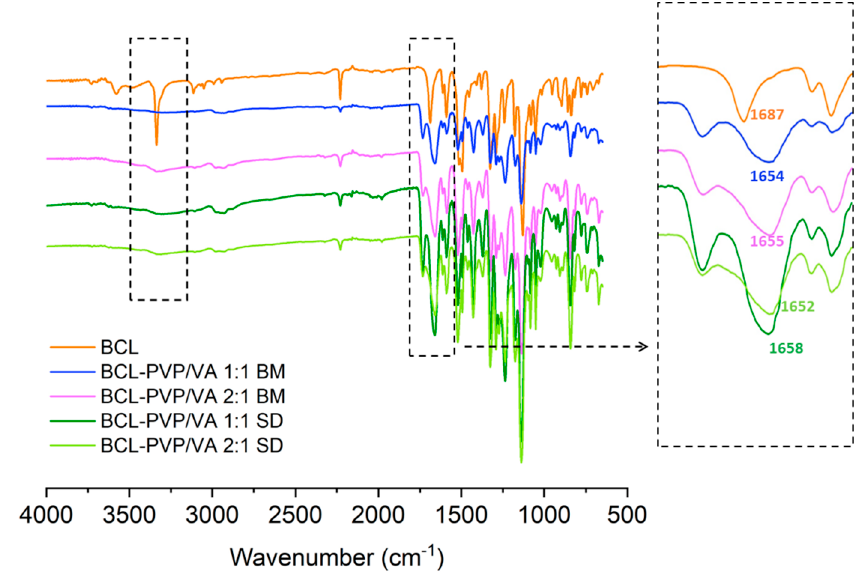
Figure 8. Fourier Transform Infrared (FTIR) spectra of crystalline BCL and selected solid dispersions (BM—ball milling, SD—spray drying).